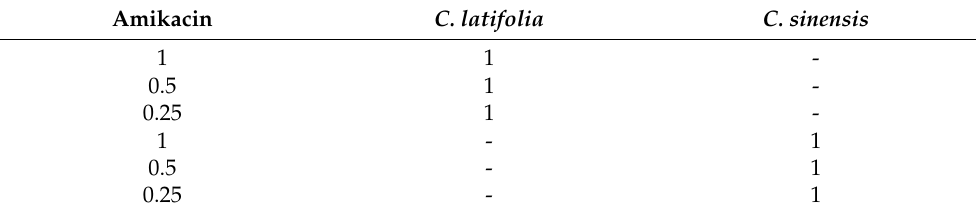
Table 4. Antibacterial + EOs concentrations ( µ g/mL) used for combination